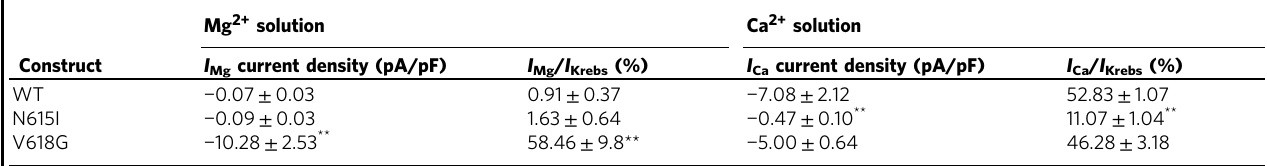
Table 1 Ion permeation of wild-type and mutant GluN2B-containing NMDARs